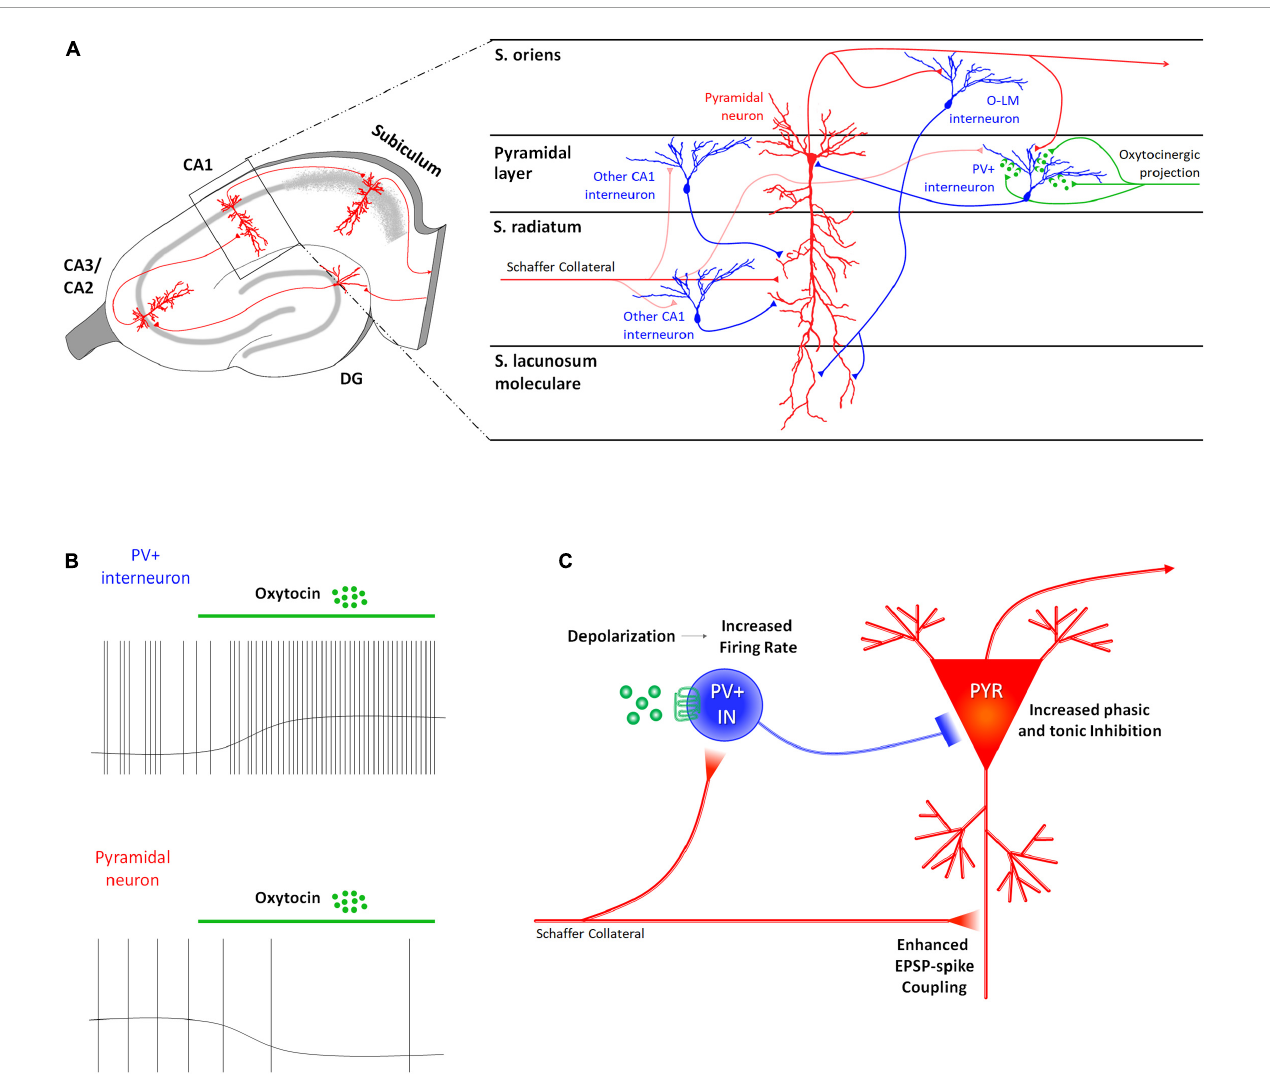
FIGURE3 Receptor distribution, oxytocinergic projections and main effects exerted by oxytocin (OT) at CA1 region of the rodent’s hippocampus. (A) At the CA1 region, OTRs are expressed only by parvalbumin positive GABAergic interneurons (PV + INs–blue) that receive direct oxytocinergic terminals (green) and whose cell body is located in the pyramidal layer. (B) In CA1, OT directly depolarizes PV + INs by increasing their firing rate and indirectly (by interposition of PV + INs) hyperpolarizes pyramidal neurons (PYR) by determining a reduction in their firing rate. (C) The OT-dependent increased excitability of the PV + INs indirectly modulates the excitability of the PYRs by increasing both phasic and tonic inhibition onto them, suppressing in turn spontaneous firing of the PYRs (reduction of noise). At the same time, OT-dependent increase in the firing rate of the PV + INs determines a “use-dependent reduction” of efficacy of the inhibition resulting in a more effective mono-synaptic excitatory transmission and a reduced di-synaptic inhibitory transmission arriving from Schaffer collaterals, entailing the enhancement of the EPSP-spike coupling (increase of signal). These two effects improve the fidelity and temporal precision of the information transfer through this